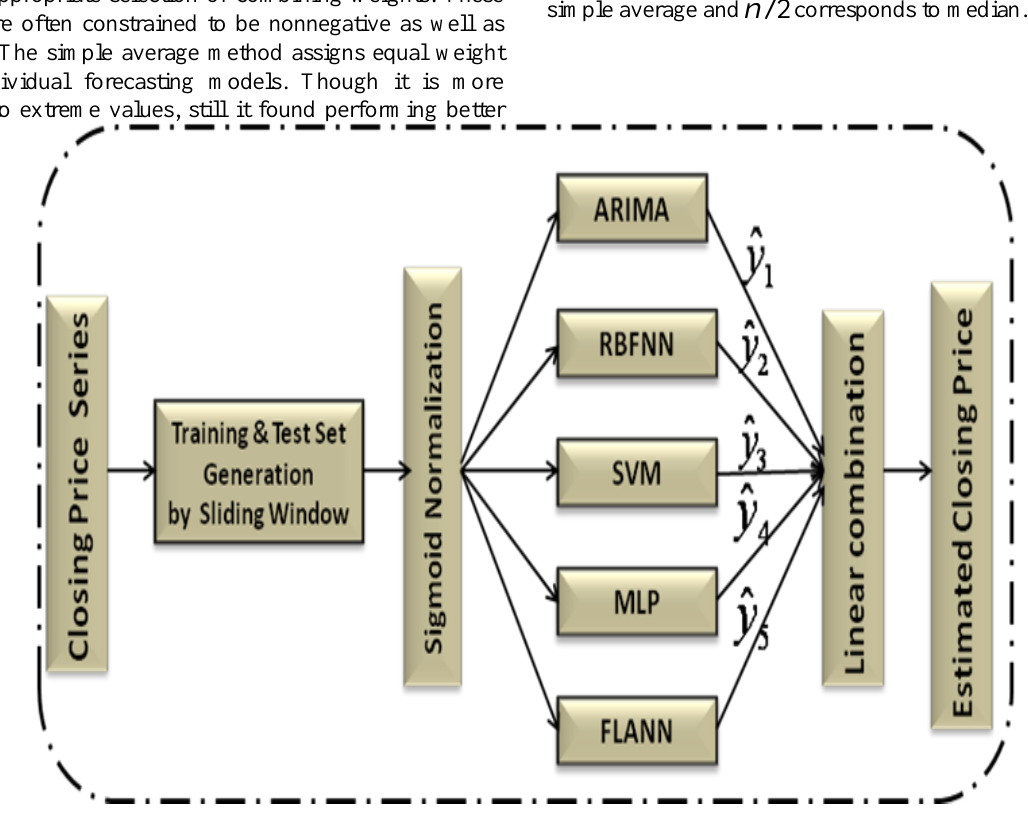
Figure 4 . Linear combination of